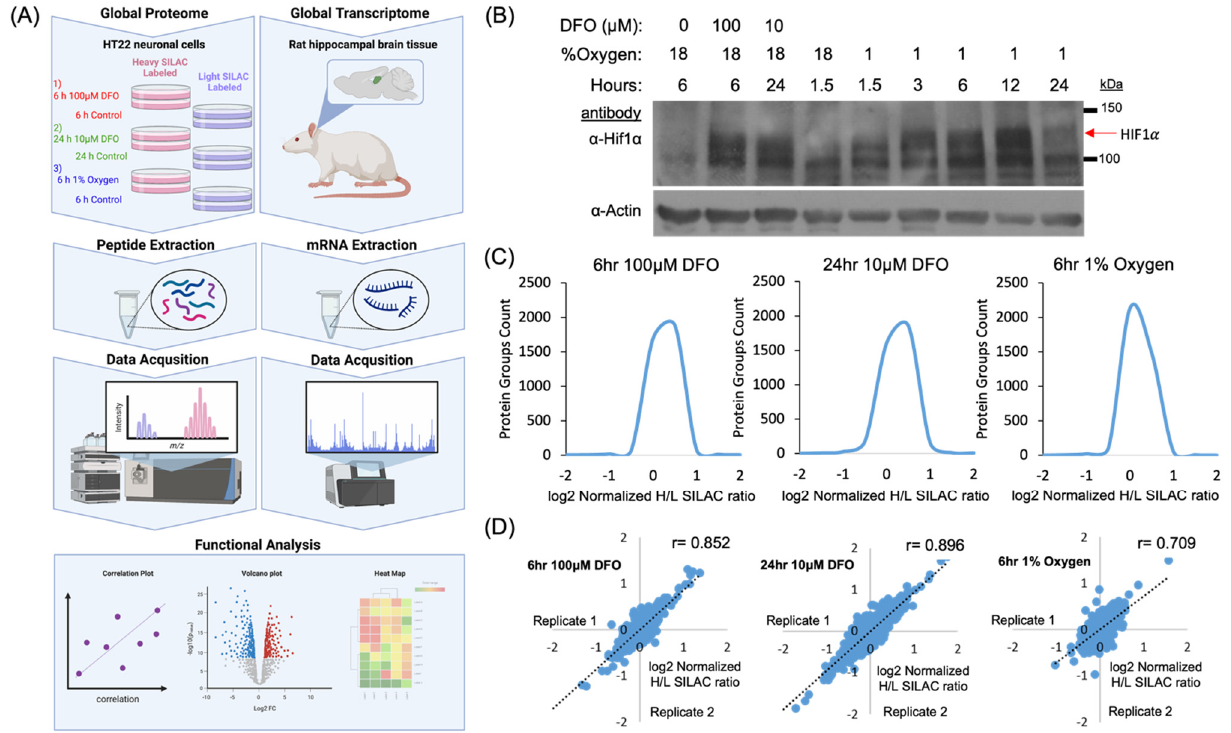
Figure 1. Experimental design for comprehensive analysis of the global proteome. ( A ) Outline of experimental workflow for comprehensive analysis of the global proteome and transcriptome. To study the global proteome, stable isotopic labeling of amino acids in cell culture (SILAC)-labeled HT22 cells were treated under hypoxic and iron deficient conditions. Peptides were extracted and characterized by mass spectrometry. To study the global transcriptome, hippocampal tissue from iron-deficient rat (P15) were extracted. mRNA was purified and characterized by a microarray study reported previously [36]. Both datasets were processed using functional analysis tools. ( B ) Western blotting of HT22 cells treated with either 100µM DFO for 6 h, 10M DFO for 24 h, or 1% oxygen for 1.5, 3, 6, 12, and 24 h and their respective non-treated controls. Red arrow indicates HIF1A. ( C ) Protein groups count distributed by normalized H/L SILAC ratio. ( D ) Plots showing biological replicate sample correlation after quantification of protein SILAC ratios.